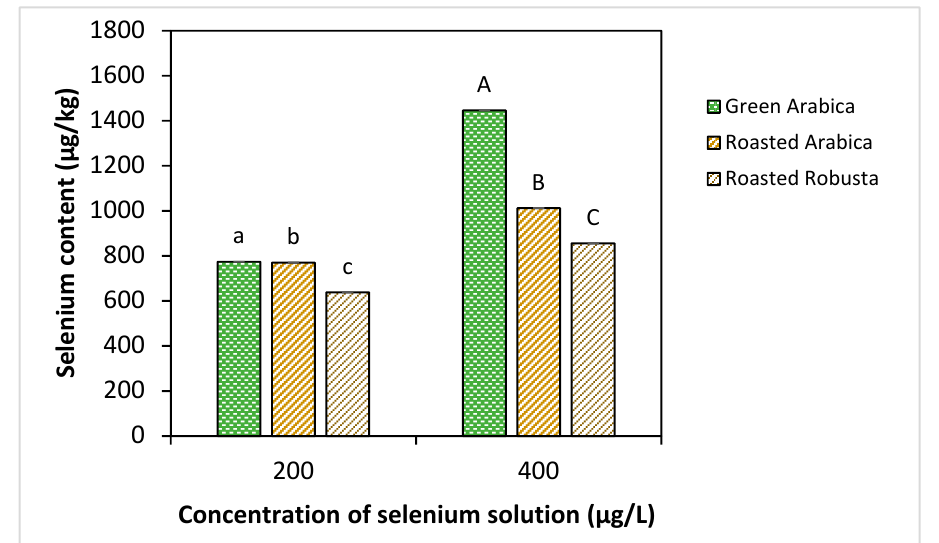
Figure 1. Selenium content of green Arabica, and roasted Arabica and Robusta Se-coffee beans ( μ g/kg) pretreated at different selenium concentrations and roasted via conventional roasting. Lowercase and uppercase letters represent significant differences ( p < 0.05) between samples at low and high selenium concentrations, respectively.